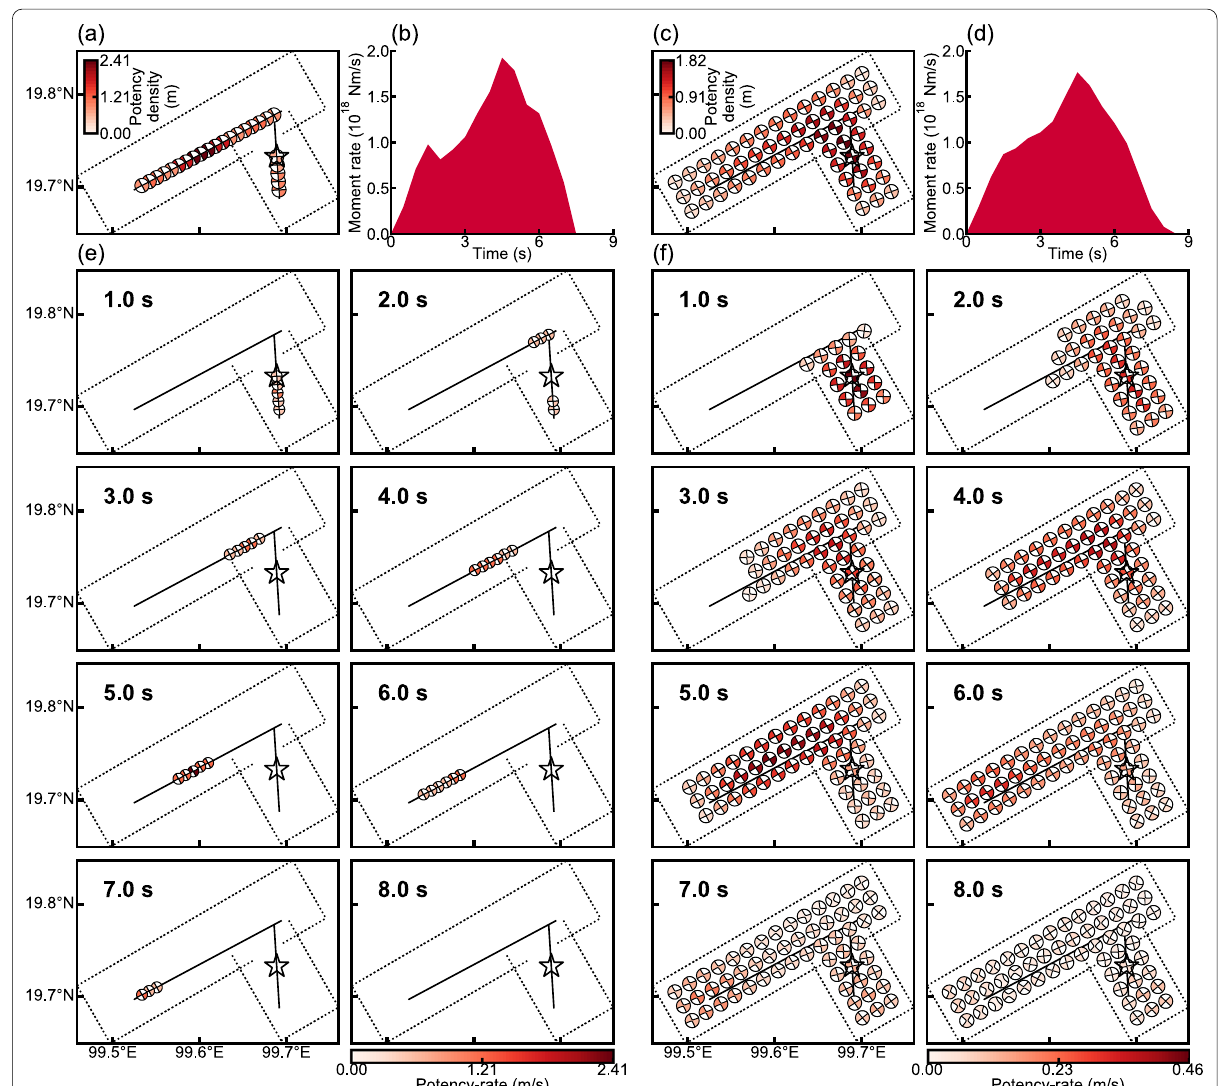
Fig. 5 Summary of the numerical test. a The map view of the input potency density tensors. b The input moment rate function. e The spatiotemporal distribution of the input potency-rate density tensors. Only the nonzero potency-rate density tensor located at the same depth as the hypocenter is shown. c – f Similar as the panels a – c but for the output solution. The star indicates the initial rupture point. The solid lines show the input faults. The dotted line denotes the assumed horizontal model